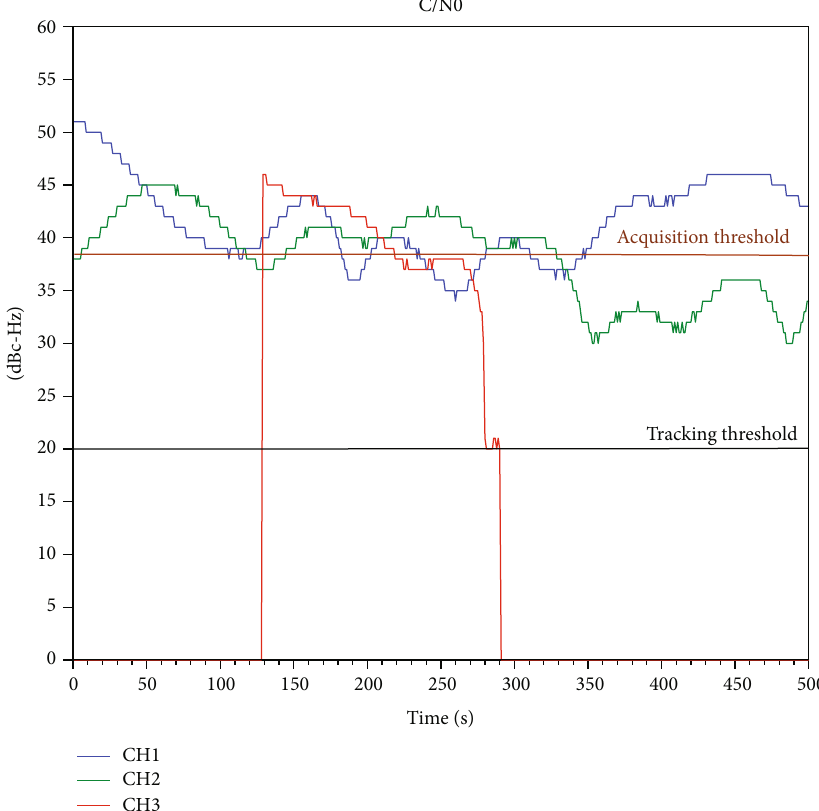
Figure 14: Development of the C/N0 of selected satellites. The oscillation is caused by a satellite rotation. The receiver uses a software tracking threshold 20dBc-Hz. If the signal falls below this value, the reacquisition is started.